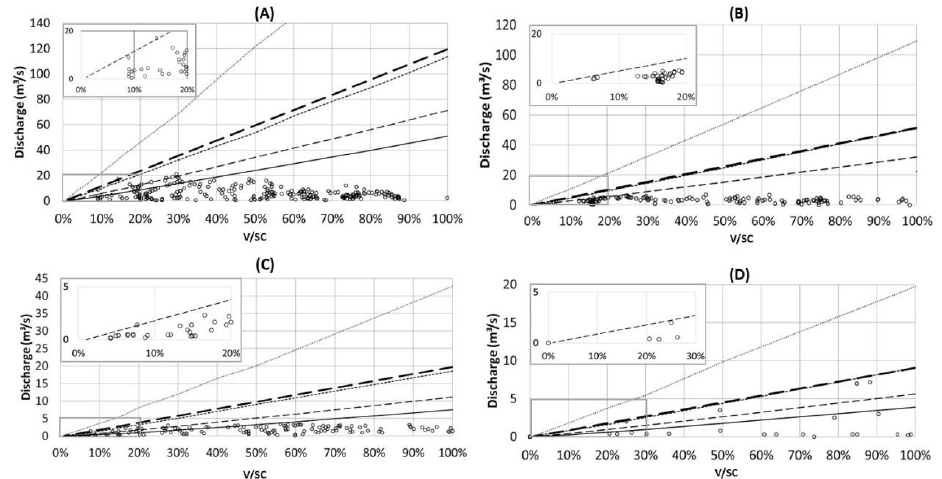
Figure 4. Field data (dots) and simulation (lines) of released discharges as a function of the reservoir volumes (V) divided by the storage capacities (SC) for several values of depletion duration (T). The continuous black line refers to T = 12 months; the dashed line to T = 9 months; the dotted line to T = 6 months; and the continuous grey line to T = 3 months. The bold dashed line refers to the calibrated depletion duration T, as described in Section 2.5. The small box on the top right zooms the optimal curve and the field data near the most external point: ( A ) Orós; ( B ) Araras; ( C ) Pentecoste; and ( D ) Aracoiaba.